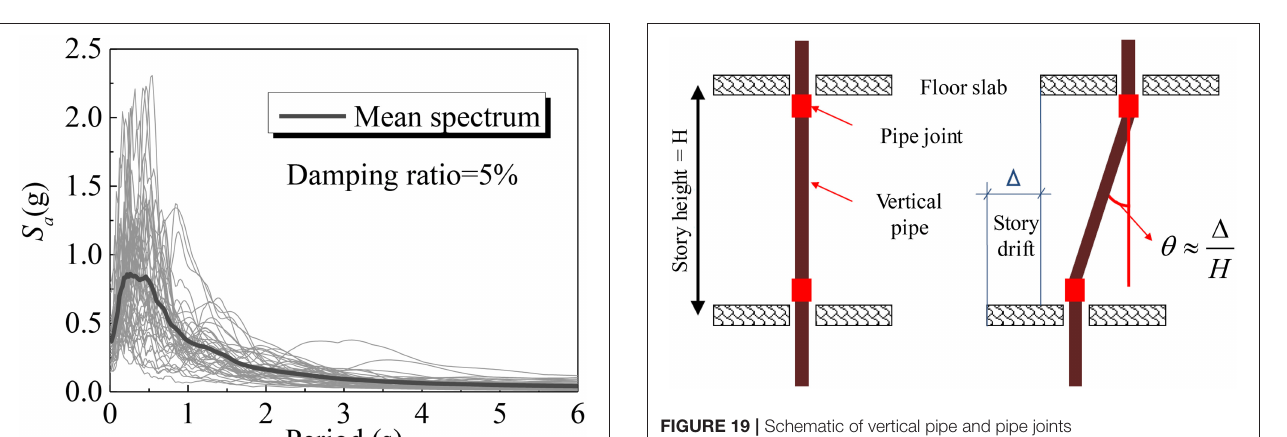
FIGURE 19 | Schematic of vertical pipe and pipe joints (Soroushian et al.,